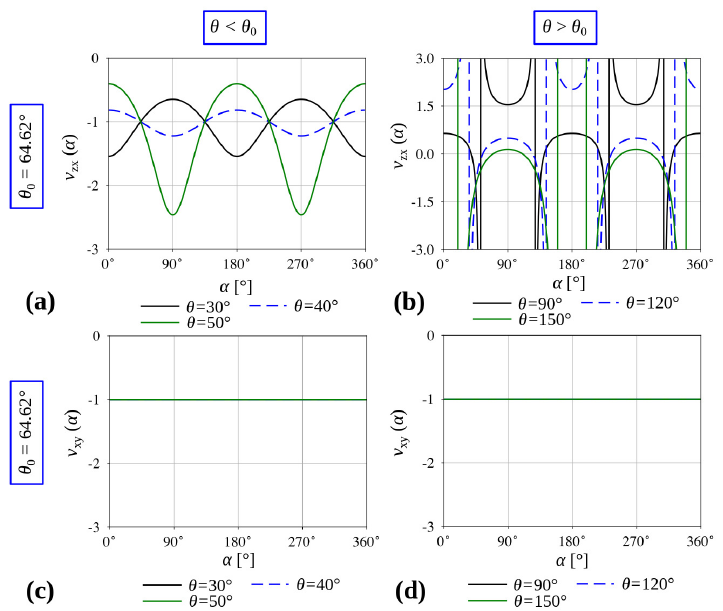
Figure A2. Panels show analytical results corresponding to a system with parameters matching those used in the experiment for loading in ( a , b ) xz plane and ( c , d ) xy